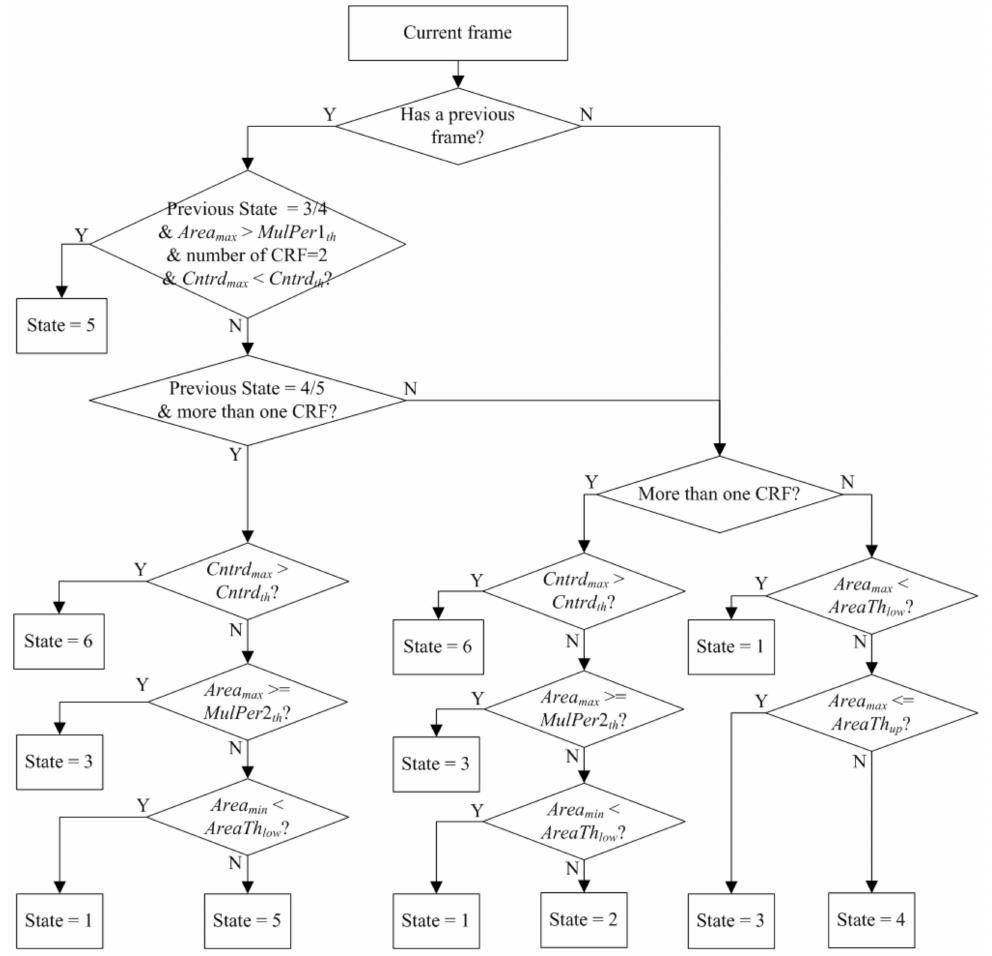
Figure 8. Flowchart of the state definition (CRF, circumscribed rectangular